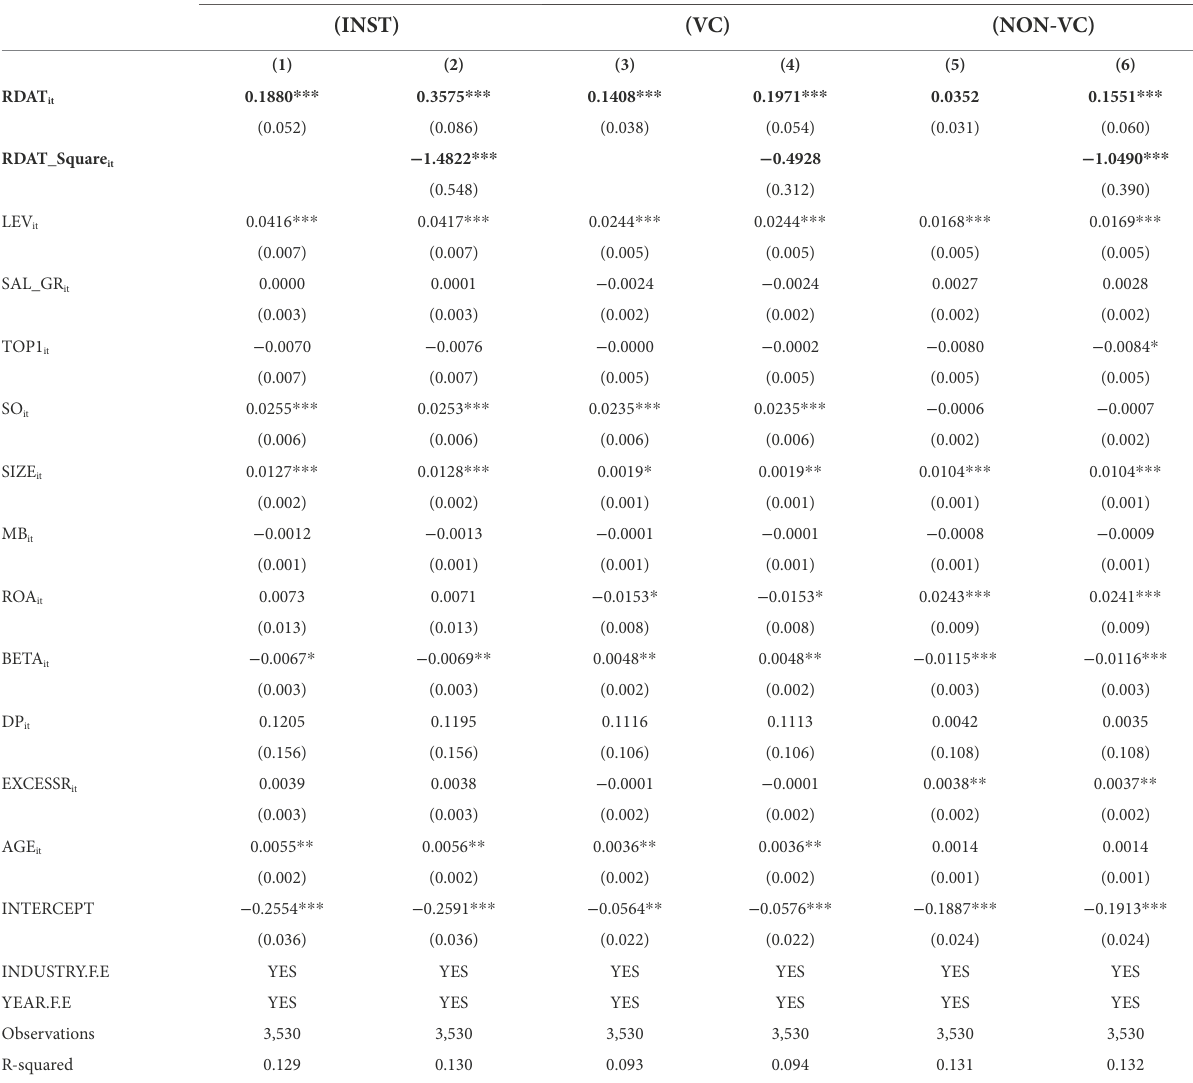
TABLE 3 Future institutional investment and R&D